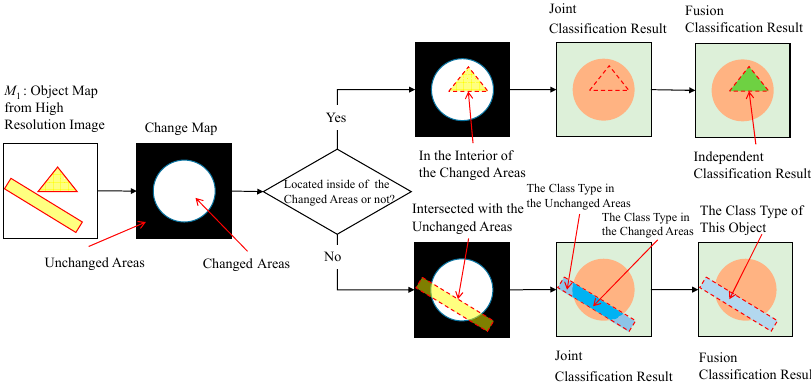
Figure 5. Diagram for the object-based post-classification fusion. If the object is totally in the interior of the changed area, its class type is determined with the independent classification result. Otherwise, if the object intersects with the changed area, its class type is determined mainly while considering the joint classification result in the unchanged area.